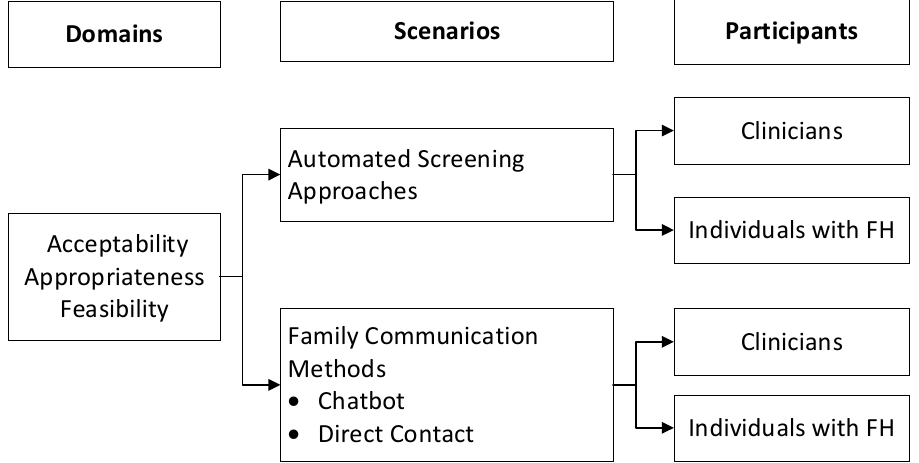
Figure 4. Analytic framework for reviewing domains by scenario and participants.